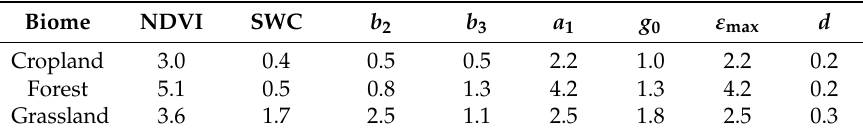
Table 2. Sensitivities of modeled ET to changes (max[ VR +10% , VR − 10% ]) in key variables and parameters. NDVI: Normalized Dynamic Vegetation Index; SWC: soil water